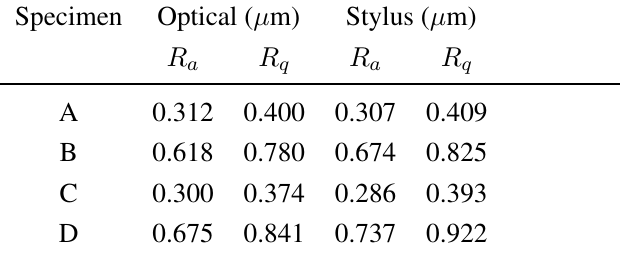
and R factors in microns calculated using our optical a q